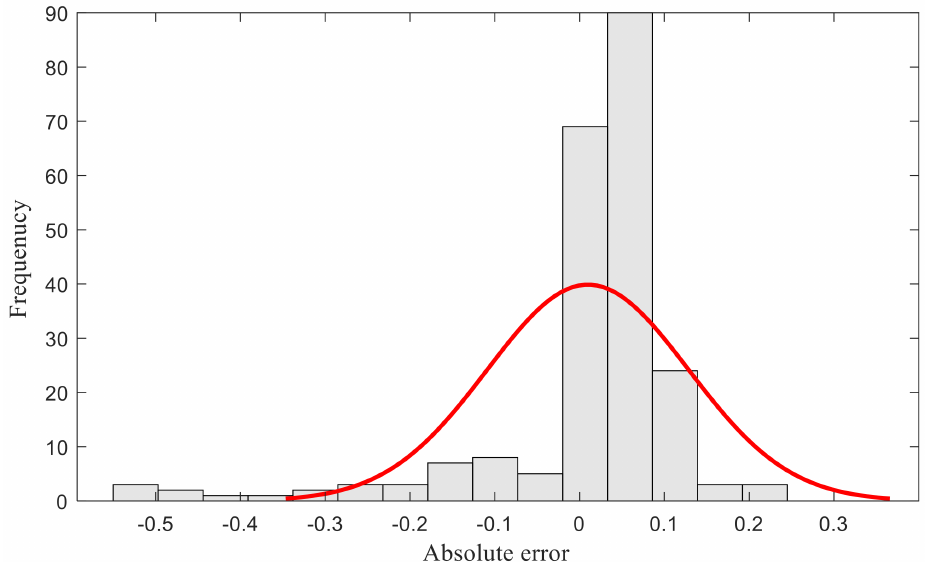
Figure 7. Histogram of residuals for the gradual gas injection